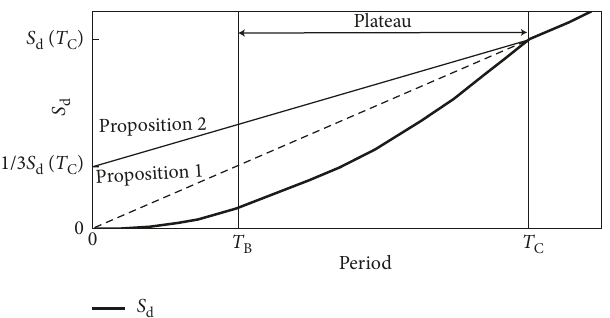
Figure 2: A linear relationship of the displacement demand with respect to the period (proposition 2) is used as a limitation of the displacement demand prediction in the period range close to the end of the plateau (i.e., for periods shorter but close to T